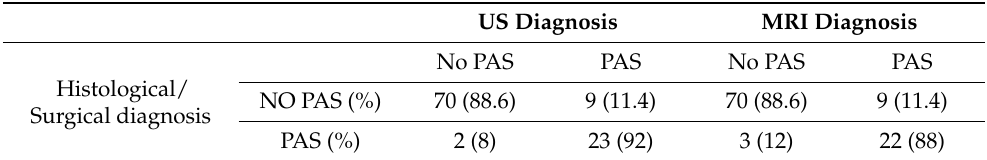
Table 3. Histological/surgical diagnosis vs. US/MRI in differentiating PAS from NO-PAS cases. US